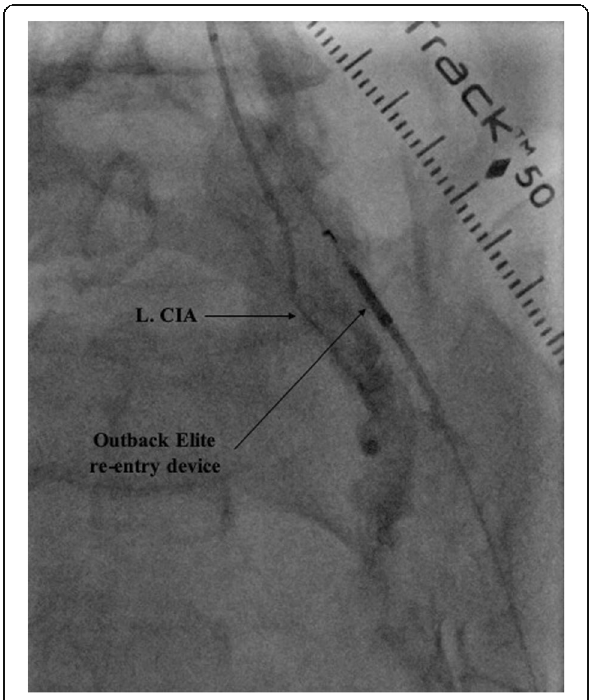
Fig. 3 An angiogram showing advancement of the Outback Elite re-entry device (Cordis) into the dissection plane adjacent to the left common iliac artery (L.